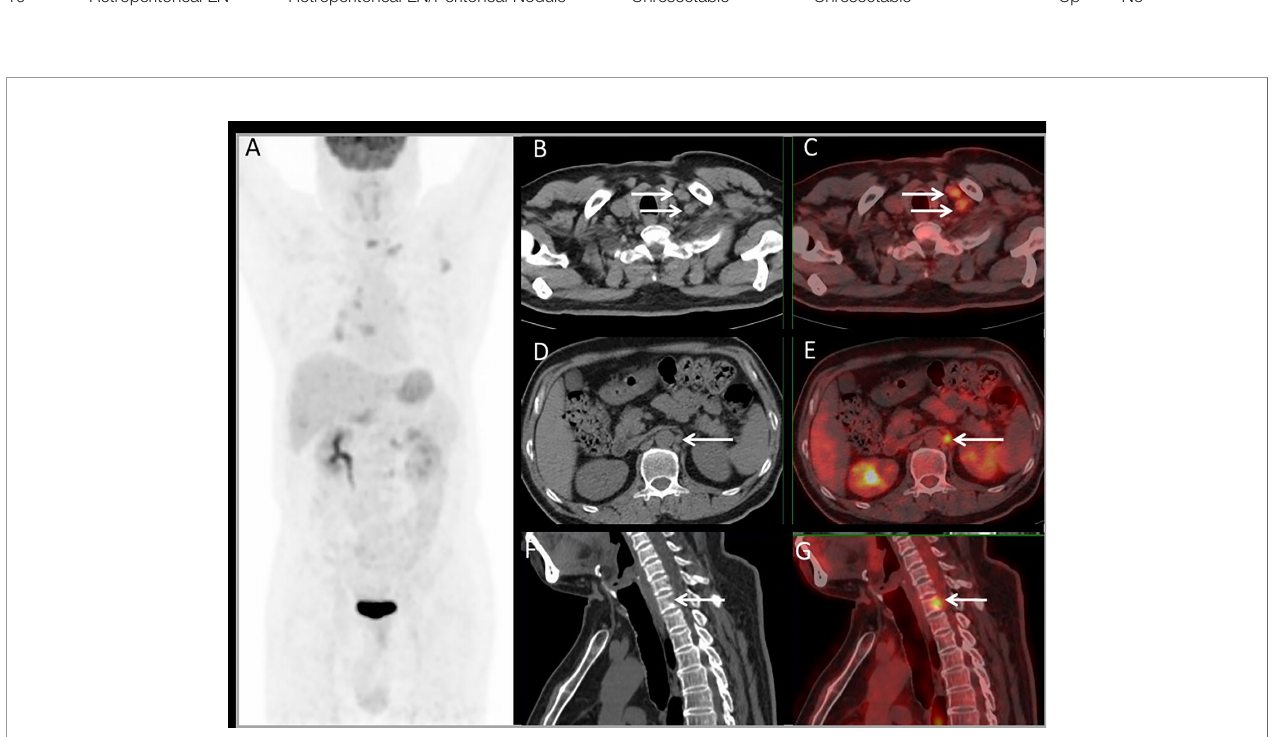
FIGURE 6 | Images of a 54-year-old male with rectal liver metastases. Common CT showed no EHD. The MIP (A) of PET/CT showed liver metastasis and multiple EHD. PET and PET/CT fusion images showed left supraclavicular lymph nodes metastases (B, C) , retroperitoneal lymph nodes metastases (D, E) , and bone metastases on the 7th cervical vertebra (F, G) . The therapy strategy was changed from resectable to unresectable (major impact). The patient received systematic therapy after PET/CT restaging.